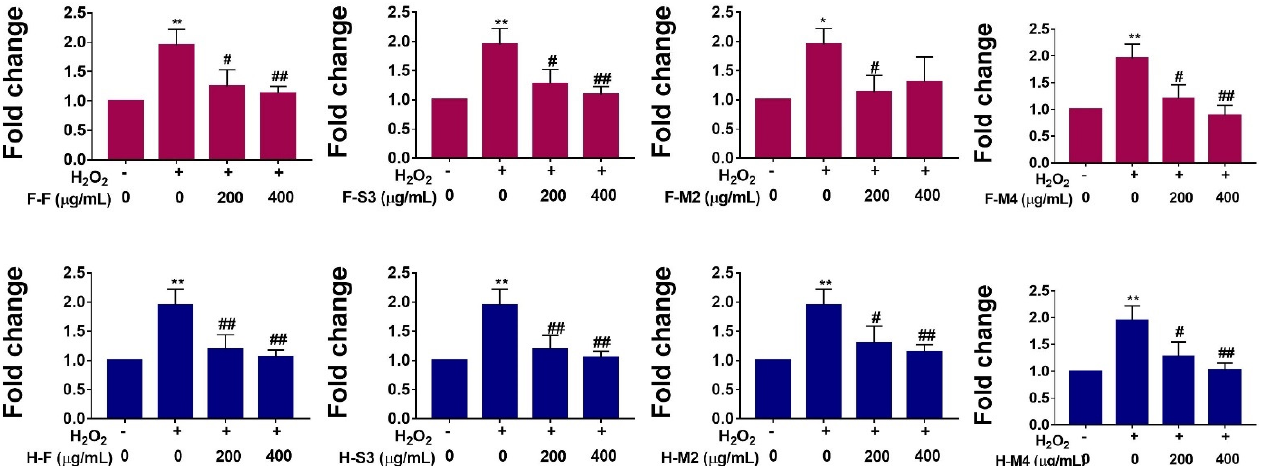
Figure 4. Broccoli extracts (fresh-hot-air-dried (H-F), steamed (3 min)-hot-air-dried (H-S3), microwaved (2 min)-hot-air- dried (H-M2), microwaved (4 min)-hot-air-dried (H-M4), fresh-freeze-dried (F-F), steamed (3 min)-freeze-dried (F-S3), microwaved (2 min)-freeze-dried (F-M2), and microwaved (4 min)-freeze-dried (F-M4)) inhibit H 2 O 2 -induced reactive oxygen species (ROS) production. HepG2 cells were pretreated with 200 or 400 µ g/mL broccoli extracts prior to exposure to 300 μ M H 2 O 2 for 10 min. 2 ′ ,7-dichlorodihydrofluorescein (H 2 DCFDA) diacetate was used as a probe to measure intracel- lular ROS levels. Data are expressed as mean ± standard deviation of three independent experiments. * p < 0.05 and ** p < 0.01 vs. untreated control group; # p < 0.05 and ## p < 0.01 vs. H 2 O 2 only treated group.